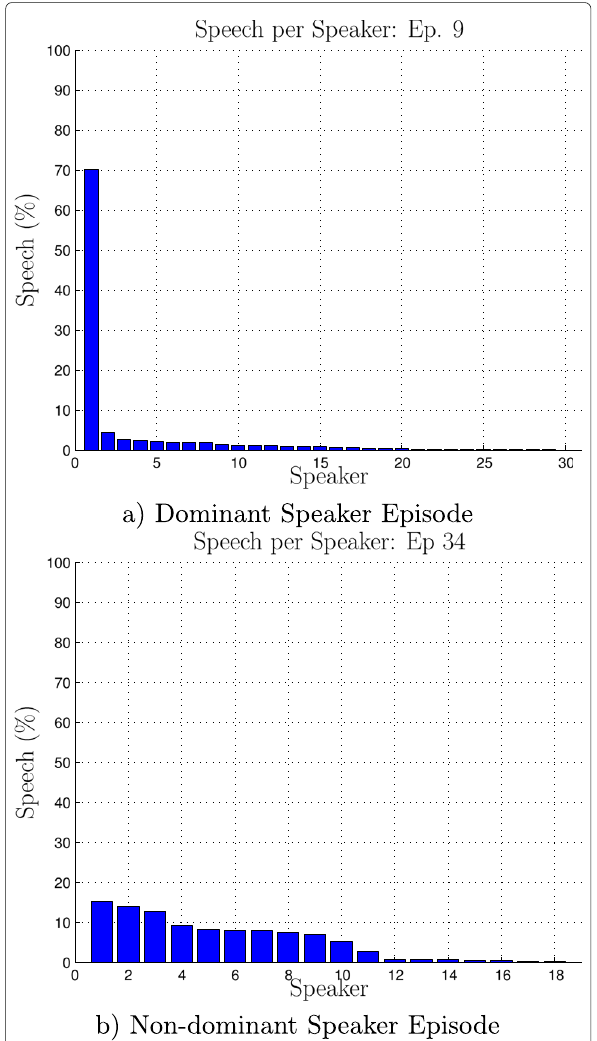
Fig. 3 Distribution of speech per speaker for two episodes: a An episode with a dominant speaker. b An episode with a more even speech distribution